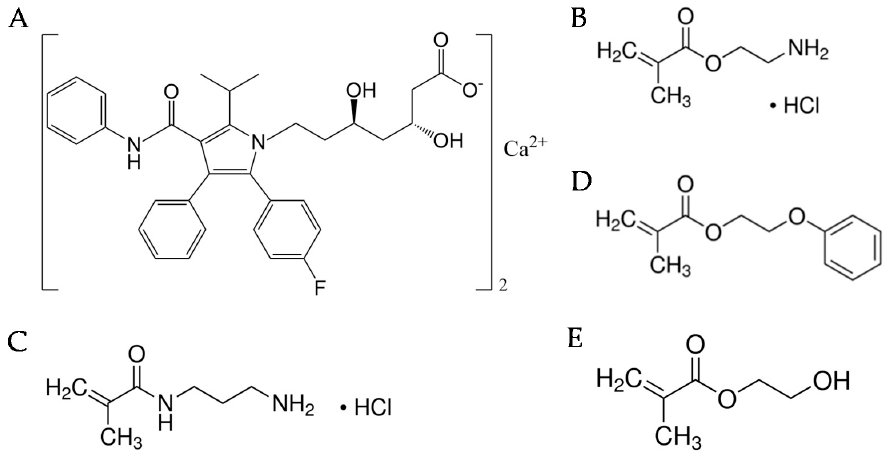
Figure 1. Structure of atorvastatin calcium ( A ) and the functional monomers used to synthesize the hydrogels: ( B ) 2-aminoethyl methacrylate hydrochloride (AEMA); ( C ) N-(3-aminopropyl) methacrylamide hydrochloride (APMA); and ( D ) ethylene glycol phenyl ether methacrylate (EGPEM), and ( E ) 2-hydroxyethyl methacrylate (HEMA). Table 1. Composition of the monomer mixtures used to synthesize the hydrogels. ni: nonimprinted; i: imprinted. Hydrogel Code HEMA